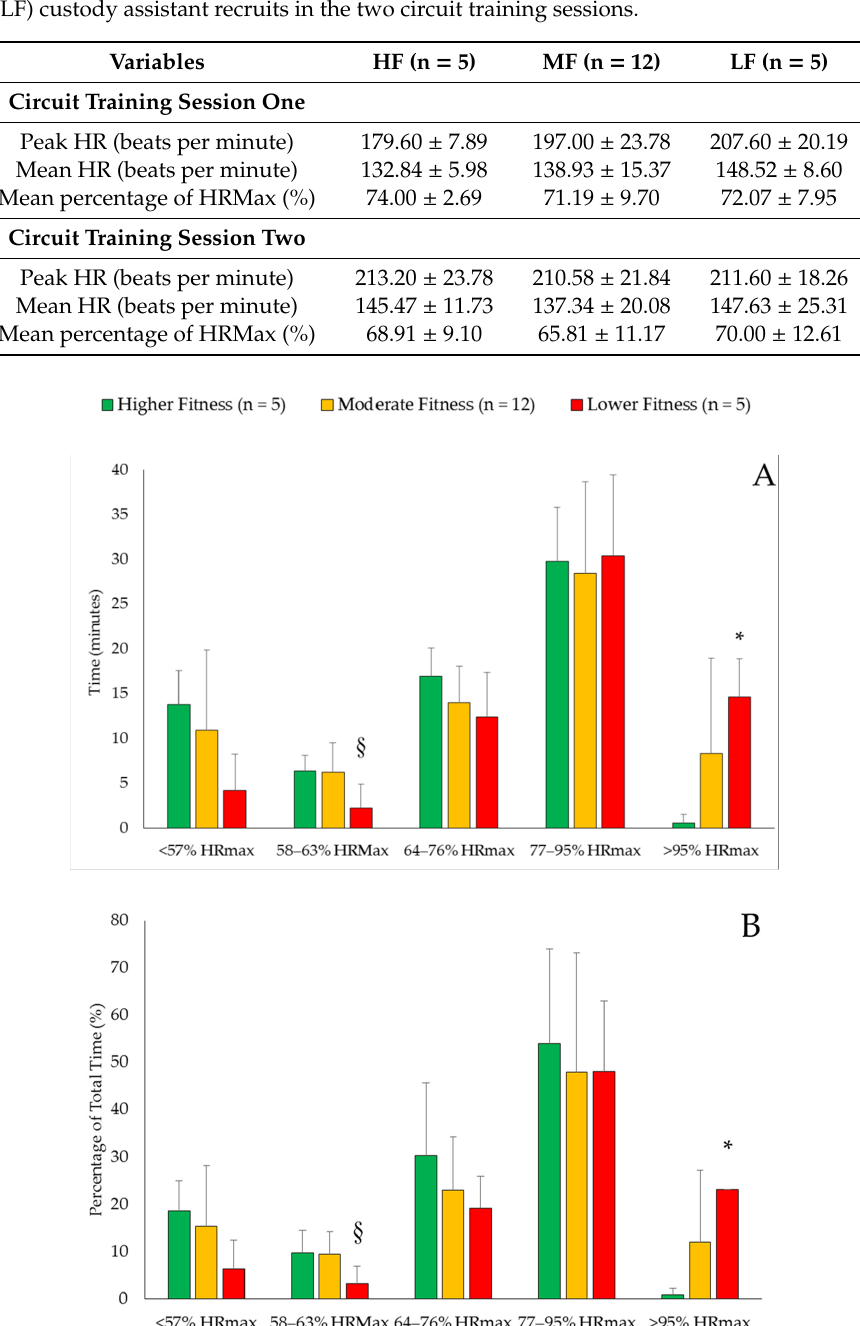
Figure 1. Time spent ( A ) and percentage of total time spent ( B ) in heart rate (HR) intensity zones defined by the American College of Sports Medicine [44] for higher fitness, moderate fitness, and lower fitness custody assistant recruits during circuit training session one. * Significantly ( p < 0.05) different from the HF group. § Significantly ( p < 0.05) different from the MF group.